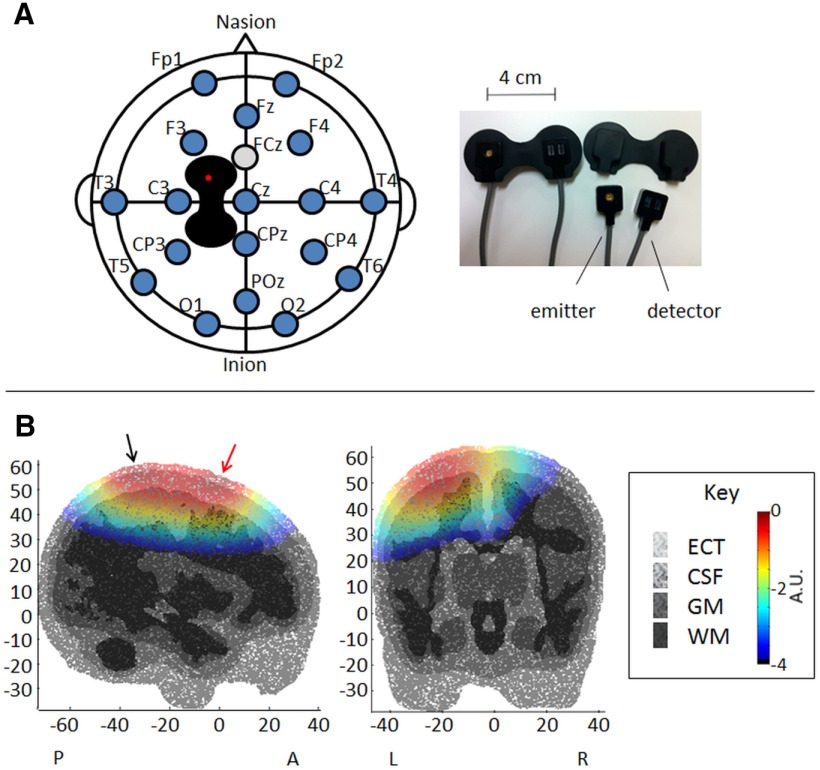
A, B, NIRS optode and EEG electrode locations (A) and NIRS sensitivity maps (B). A, NIRS optode (black) and EEG electrode (blue circles) locations are presented on a schematic of the top view of the head (left). The EEG reference electrode was placed at FCz (gray circle). The NIRS emitter and detector were placed in a holder (pictured right) at a fixed distance of 4 cm, with the emitter toward the front of the head (red dot in schematic). B, The sensitivity map of the optodes is shown at C1 (halfway between Cz and C3) in 2-mm-thick sagittal (left) and coronal (right) slices taken from a head model of 40-week-old infants. The scale bar indicates the log of the normalized sensitivity (in arbitrary units). A high sensitivity indicates that many photons pass through the given region on their way to a detector. Red and black arrows indicate the emitter and detector locations. A, Anterior; P, posterior; L, left; R, right; ECT, extracerebral tissue; CSF, cerebrospinal fluid; GM, gray matter; WM, white matter.